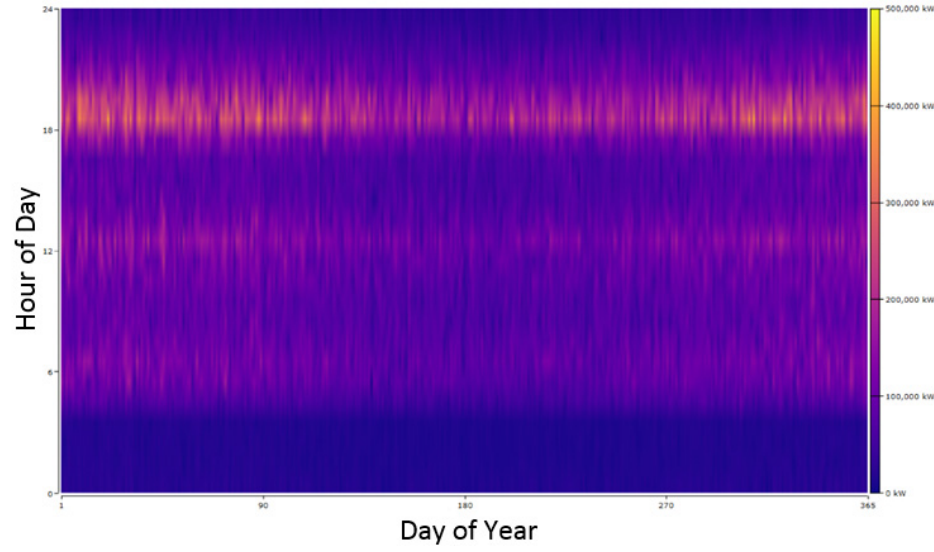
Figure 5. Heat map of energy consumption based on the input data from [24].